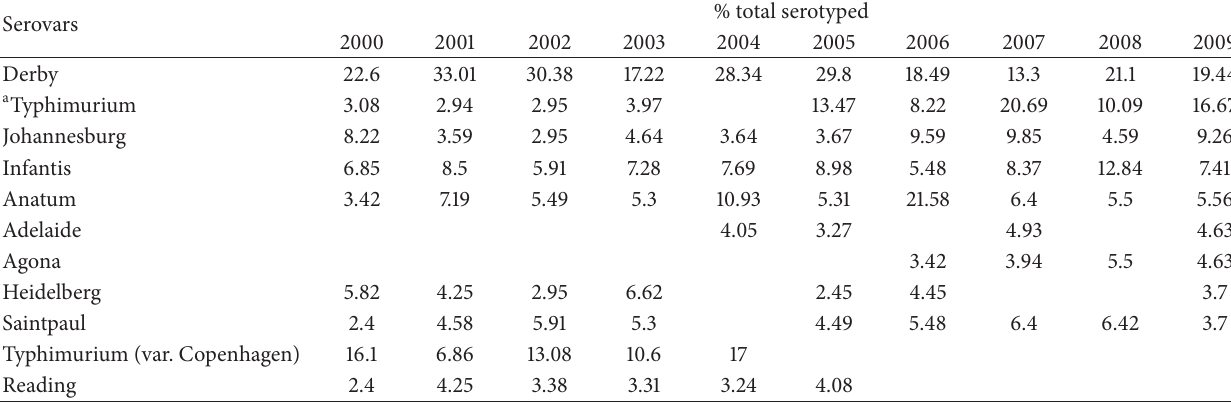
Table 13: Examples of Salmonella serovars profiles from market hogs in the US [36].